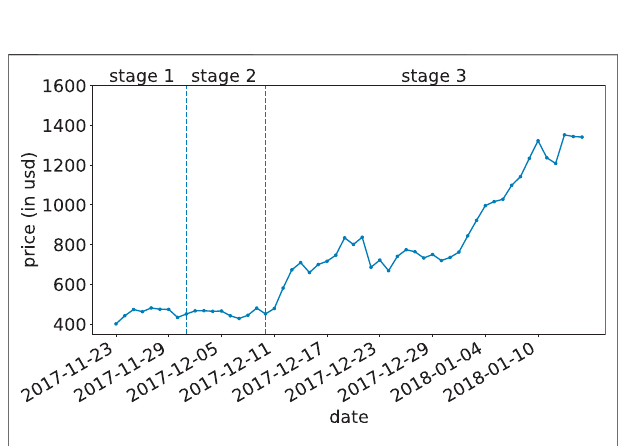
FIGURE 13 | The Ether price. Dotted lines separates the stage 1, 2 and 3.